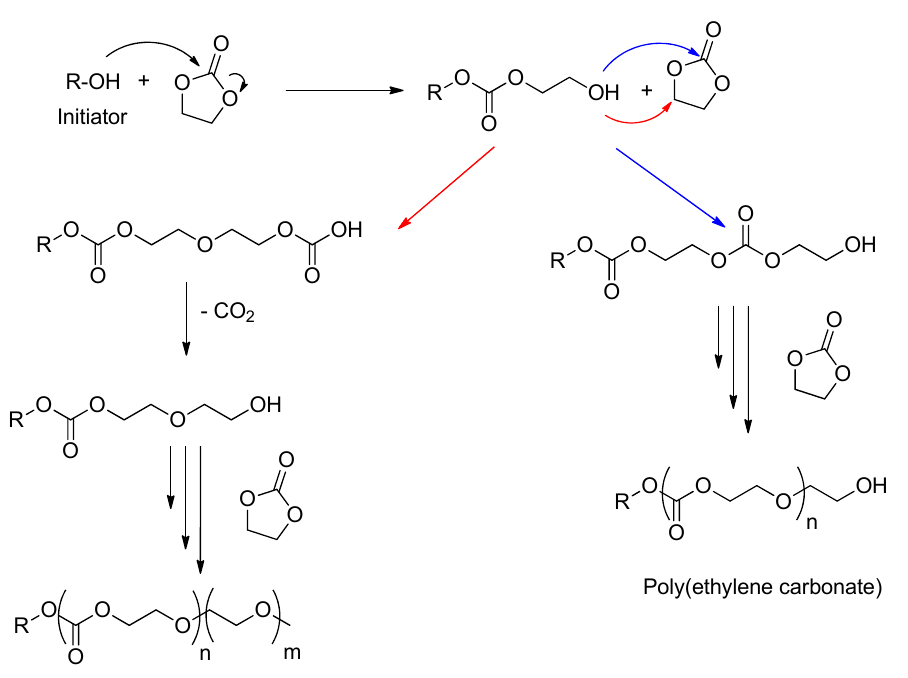
Scheme 28. Competitive pathways between methylene attack (red) and carbonyl attack (blue) to produce poly(ether-co-carbonates) or homopolycarbonates via ROP of 5-membered cyclic